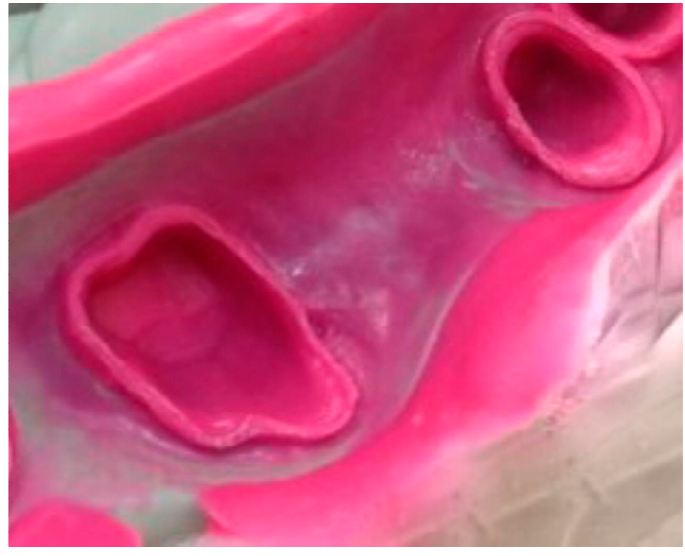
Figure 2. Two-step impression technique.